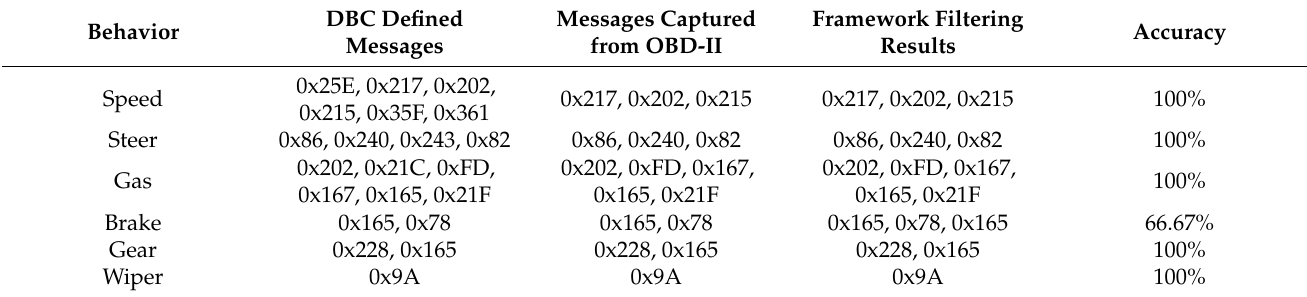
Table 6. Message filtering accuracy results for vehicle behavior.